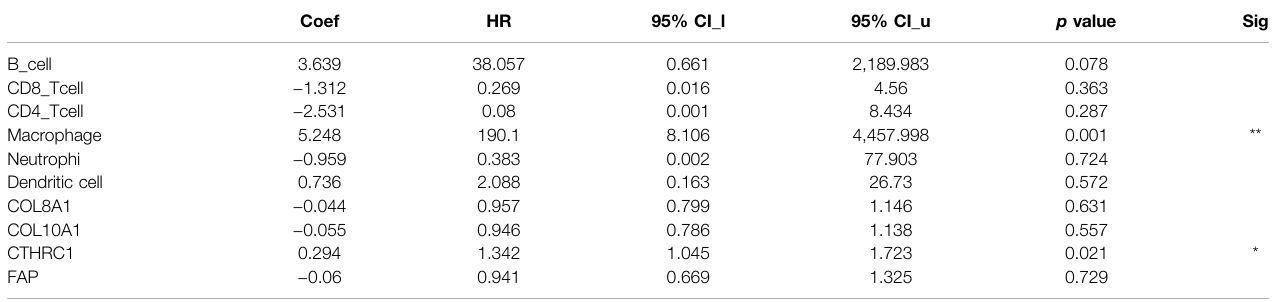
TABLE 3 | The Cox proportional hazard model of COL8A1, COL10A1, CTHRC1, and FAP and six tumor-in fi ltrating immune cells in gastric cancer (TIMER). Coef HR 95% CI_l 95% CI_u p value Sig